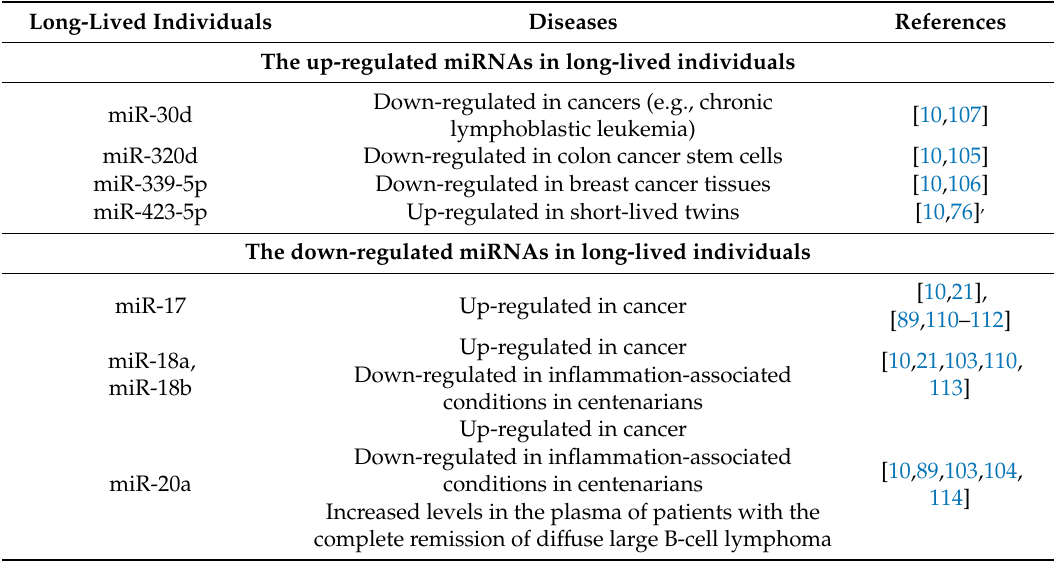
Figure 2. Role of microRNA regulation in human skin. Schematic diagram showing the involvement of miRNA in the cutaneous components’ development, aging processes, and cancer. MicroRNAs are shown as up-regulated in blue color and down-regulated in black color. This figure was created using images from Servier Medical Art Commons Attribution 3.0 Unported License. (http: // smart.servier.com). Table 2 introduces the list of age-related di ff erentially expressed miRNAs with respect to their involvement in various pathological conditions. Table 2. The association of miRNAs differentially expressed in long-lived individuals with different pathological conditions.